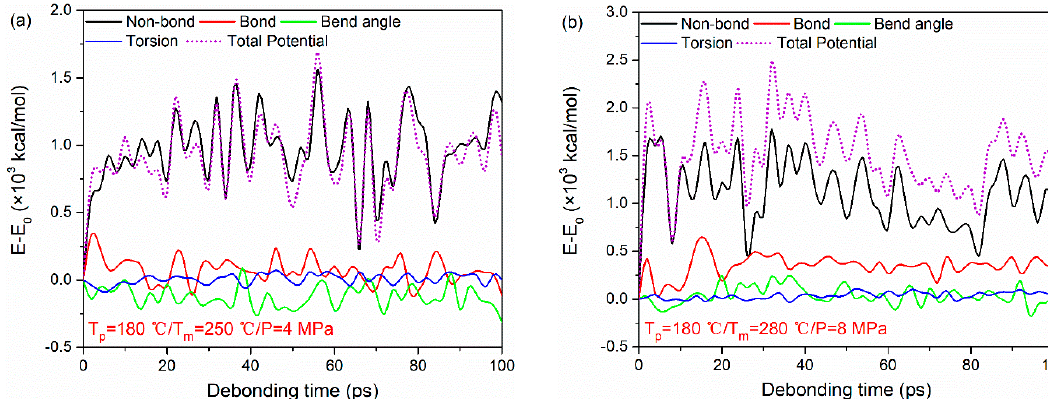
Figure 10. Potential energy decompositions of uniaxial tensile deformation process for PA66–PP interface under processing parameters: ( a ) T p = 180 ◦ C, T m = 250 ◦ C, P = 4 MPa and ( b ) T p = 180 ◦ C, interface under processing parameters: ( a ) T p = 180 °C , T m = 250 °C , P = 4 MPa and ( b ) T p = 180 °C , T m T m = 280 ◦ C, P = 8 = 280 °C , P = 8 MPa.